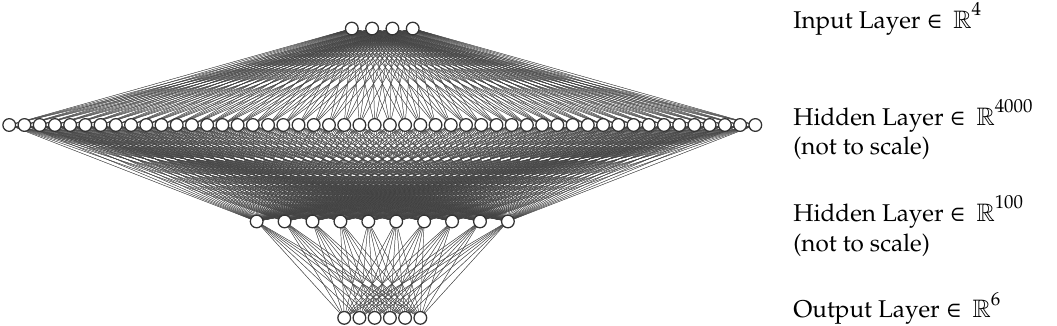
Figure 6. Sketch of the ANN used within this work, drawn using [78]. The input layer has four neurons and takes the geometry parameters w , s , h , ϕ of the specimen. The output layer has six neurons for the Biot parameters Ξ , φ , α ∞ , Λ , Λ ′ and k ′ 0 . The two hidden layers have 4000 and 100 neurons (not to scale), respectively. The activation function for all neurons is the ReLU function.